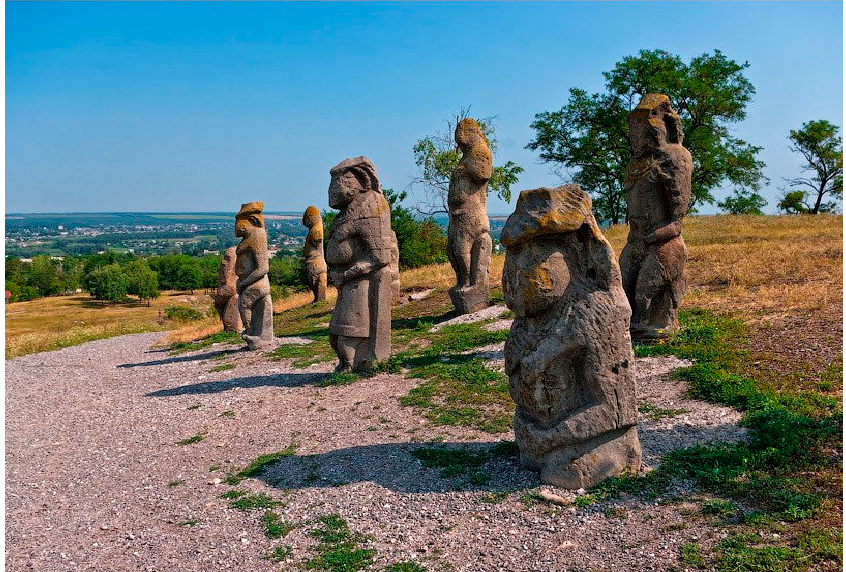
Figure 7. The babas of Polovtsy . Near Kharkiv, 12th century.